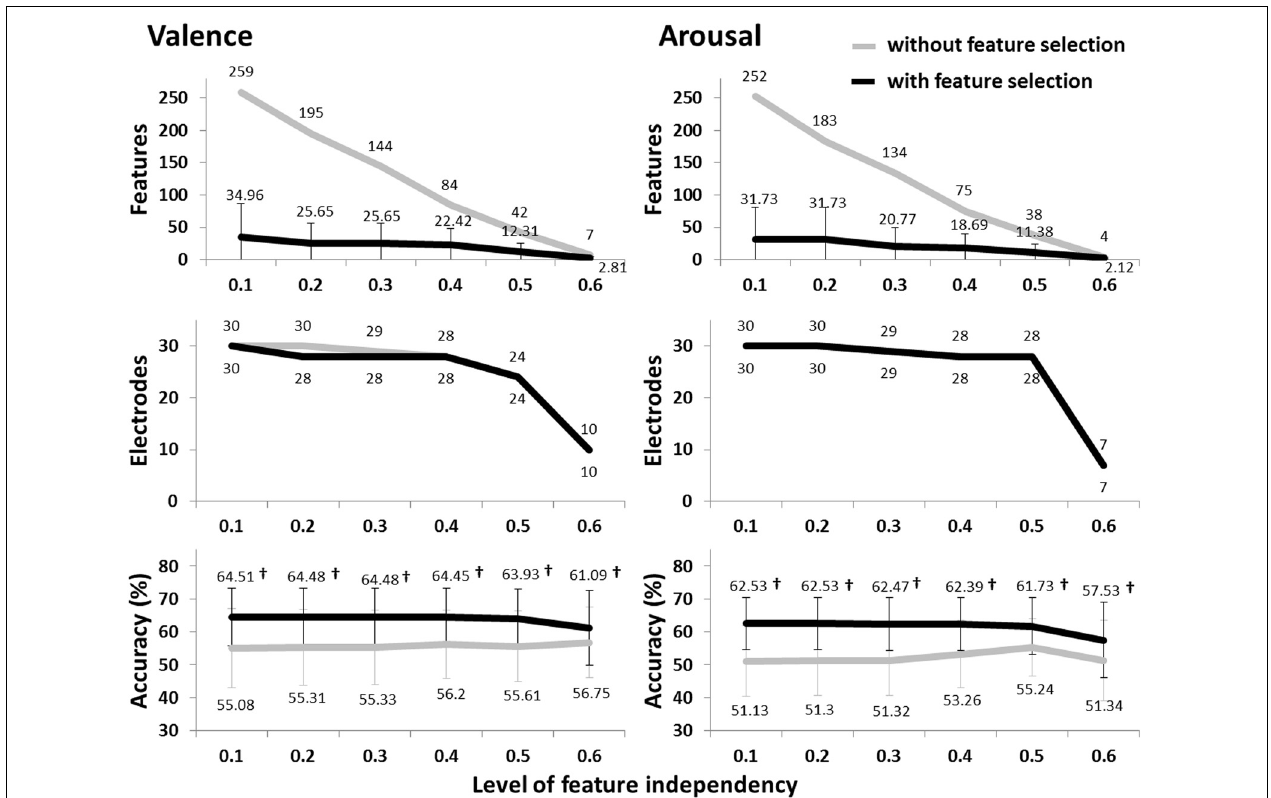
FIGURE 5 | The valence and arousal classification results of the subject-independent EEG features (type: MESH) in term of the average number of features, electrodes, and accuracies using with/without feature selection under the LFI criteria (0.1 ∼ 0.6). The numbers near to